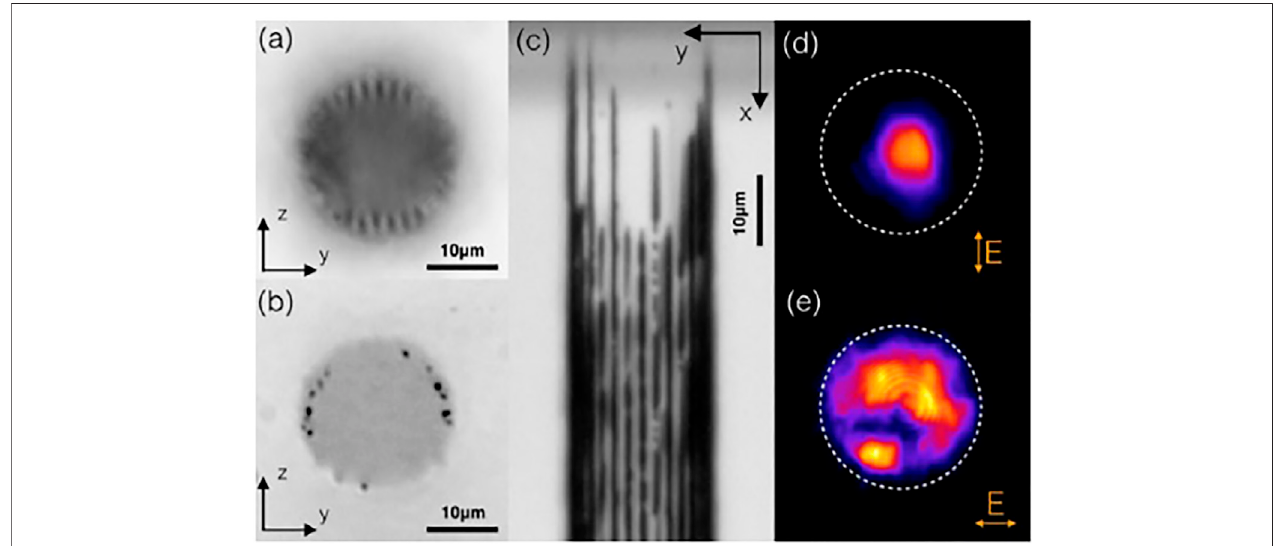
FIGURE10 | (A) Microscopy image of the sidesurface ofthe type III waveguide focused under the surface ofthe sample. (B) Microscopy image of the side surface ofthetypeIIIwaveguidefocusedonthesurfaceofthesample. (C) Topdowntransmissionmicroscopy imageofthegraphitictrackscomprising thewaveguide. Imageof the end of the waveguide with (D) vertical and (E) horizontal polarization